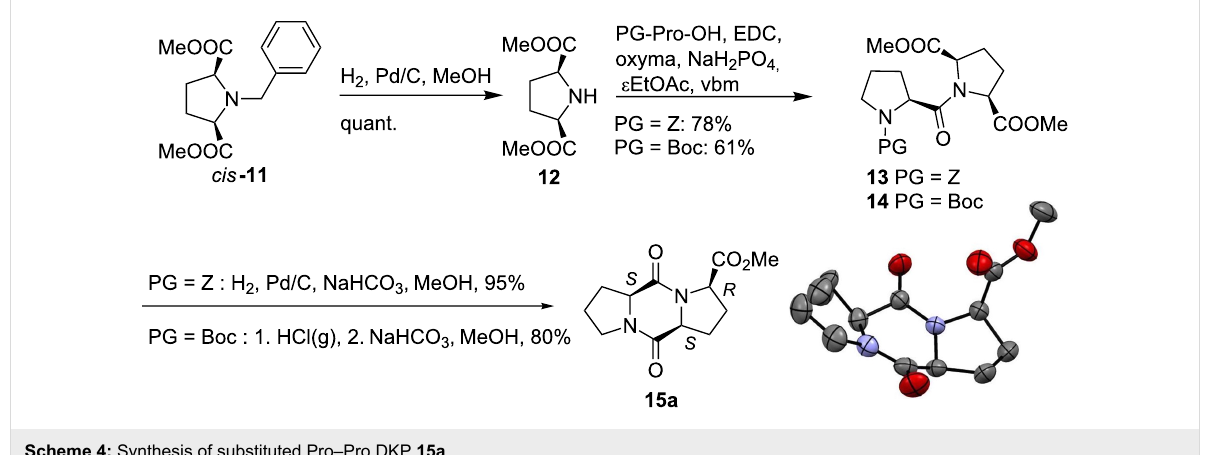
Scheme 4: Synthesis of substituted Pro–Pro DKP 15a .